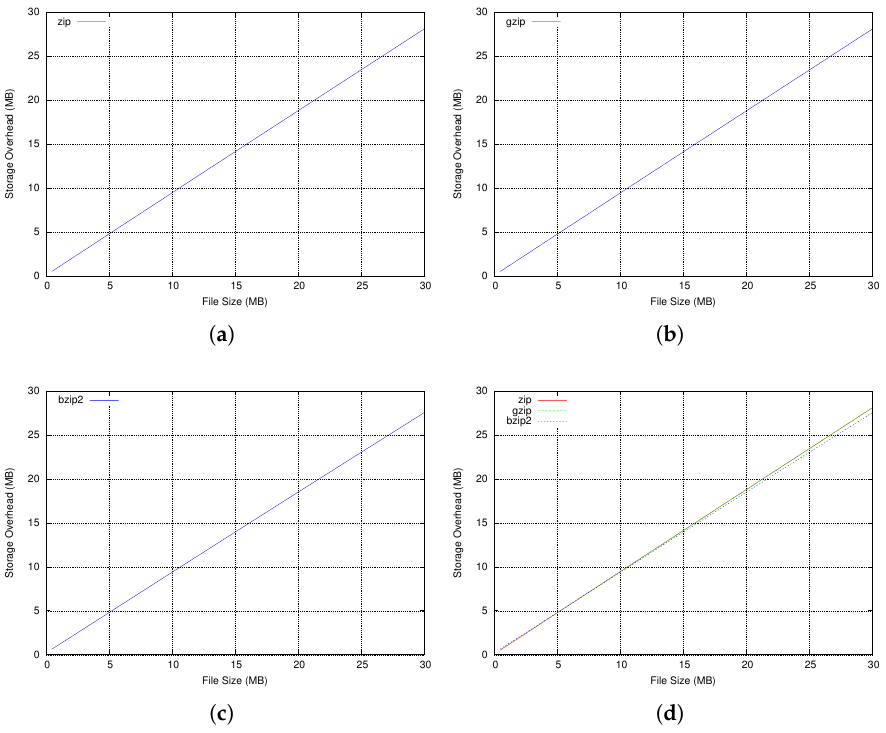
Figure 6. Storage overhead by SH-VARR snapshot based on three compression algorithms. ( a ) Using zip algorithm; ( b ) Using gzip algorithm; ( c ) Using bzip2 algorithm; ( d ) All